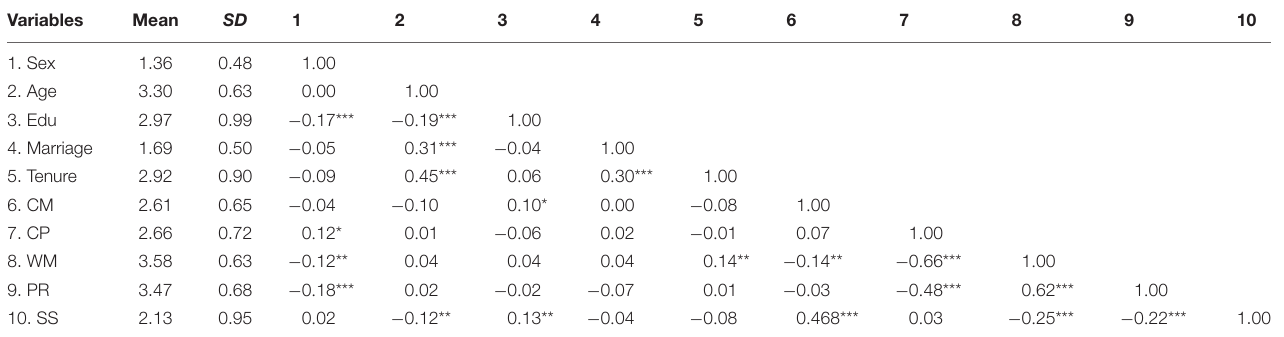
TABLE 3 | Descriptive statistics and correlations.